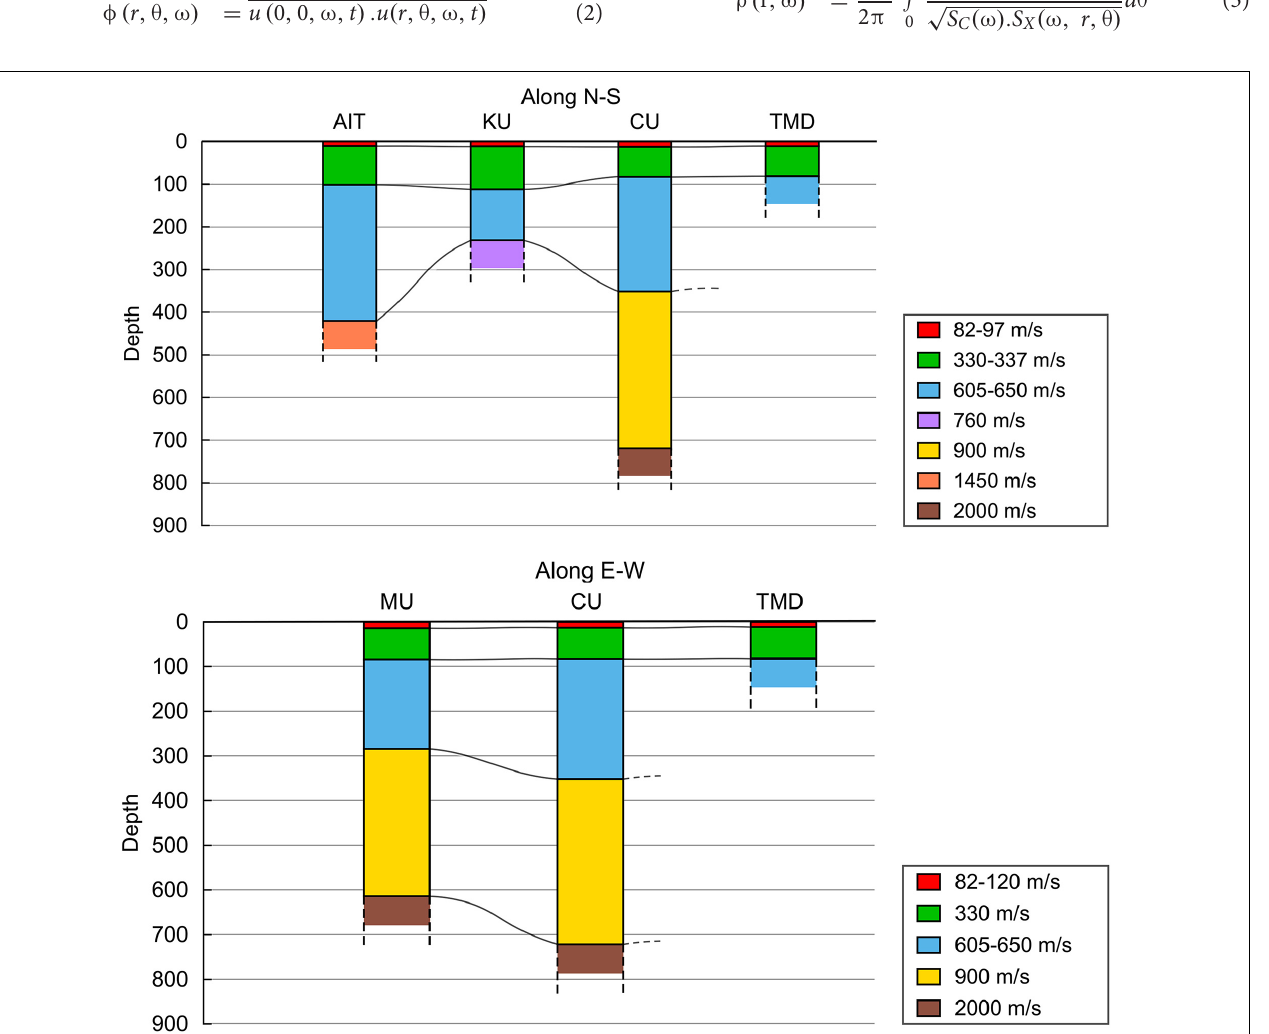
Frontiers in Built Environment |